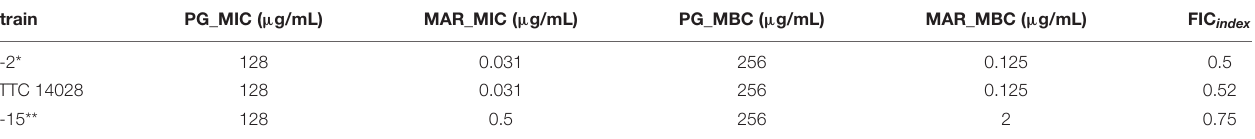
TABLE 2 | MIC, MBC, and FIC index of pyrogallol and marbofloxacin.